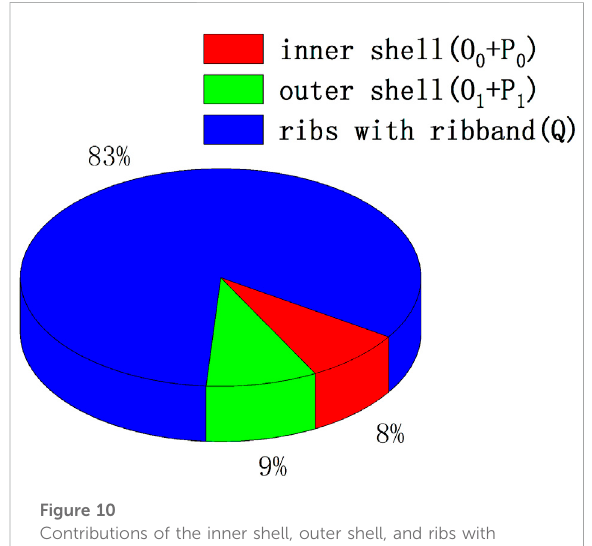
Figure 10 Contributions of the inner shell, outer shell, and ribs with ribband to global